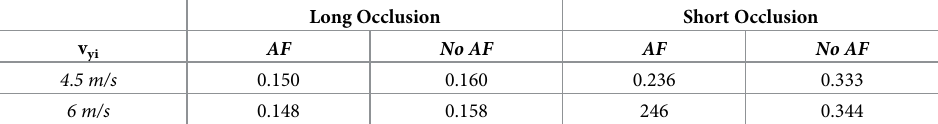
Table 2. Root Mean Squared Errors (RMSEs) between simulated and observed mean errors for simulations including the Aubert-Fleischl phenomenon (AF) and simulations that don’t (No AF). Lower values signify a better